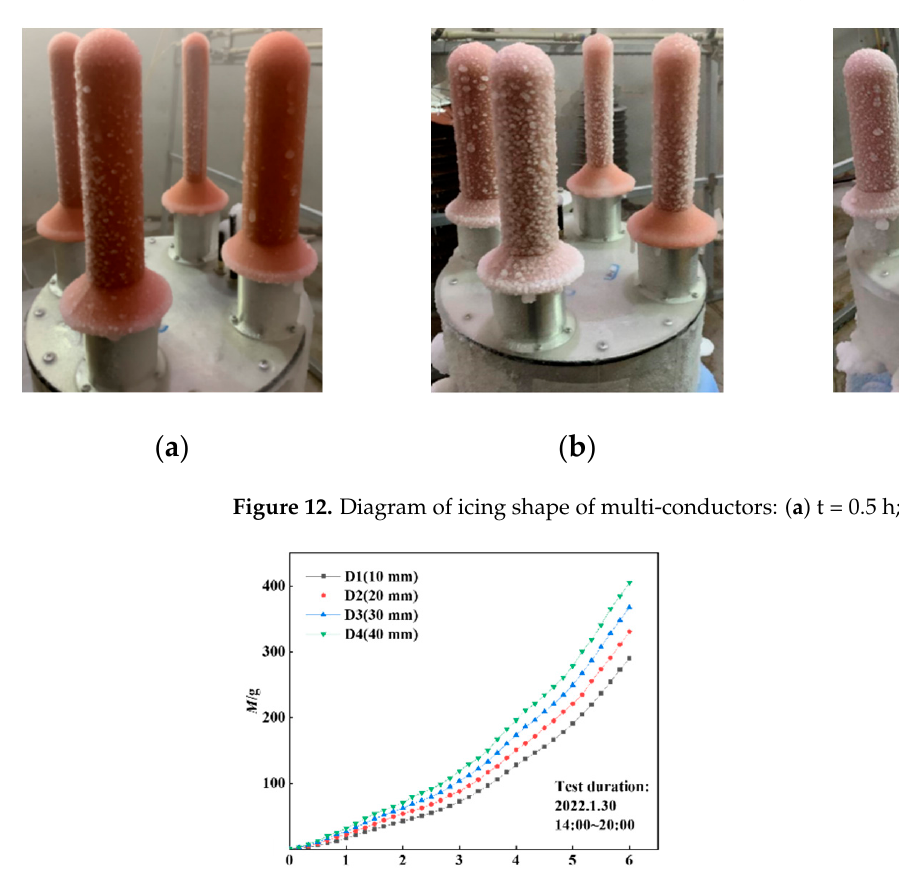
Figure 13. Icing weight of four rotating conductors.